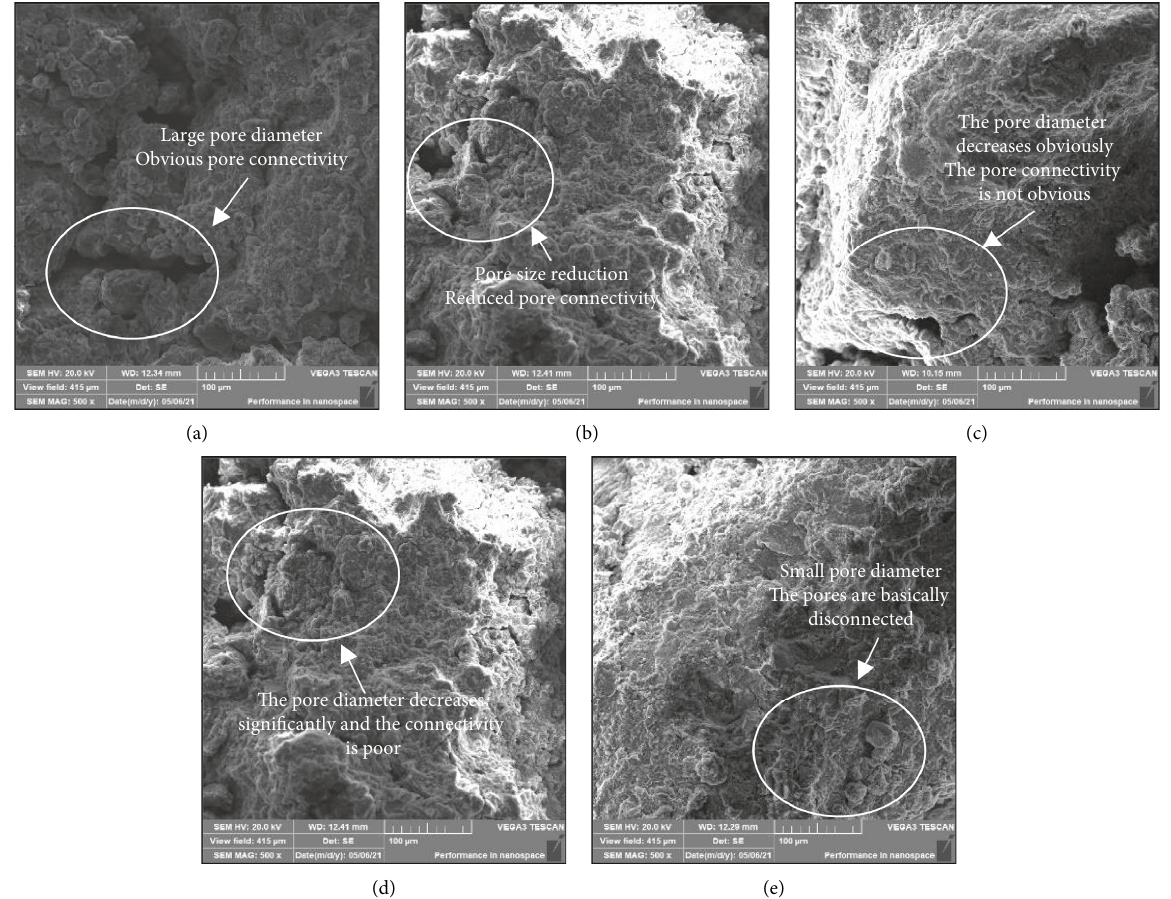
Figure 10: Microstructure images of samples soaked in FA solution with different pH values ( × 500). (a) 7.0 pH, (b) 6.0 pH, (c) 5.5 pH, (d) 5.0 pH, and (e) 4.5 pH.